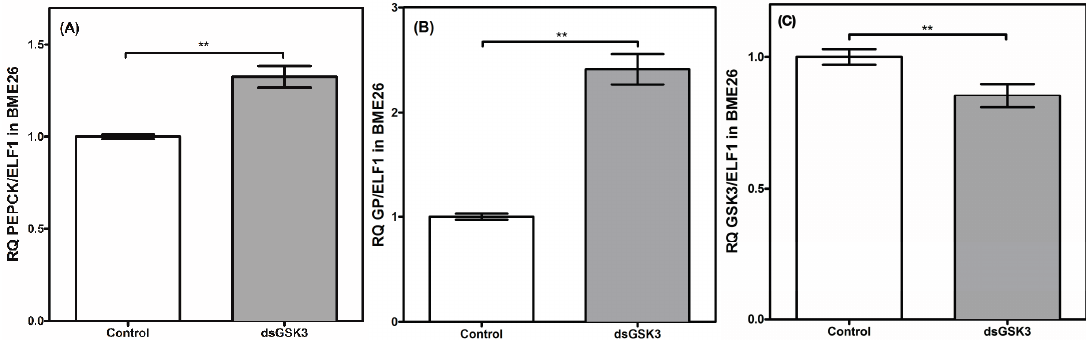
Figure 8. Gluconeogenic enzymes have transcriptional control by GSK3 in BME26 silenced-cells. Transcriptional analysis of PEPCK ( A ) and glucose-6 phosphatase ( B ), gluconeogenic key-enzymes, in embryonic Rhipicephalus microplus cells (BME26) in response to GSK3 silencing ( C ). Control: cells maintained with 50 mM of glucose; Low: cell maintained without glucose addition; and High: cells maintained with 100 mM of glucose. The experiment was performed with three independent biological samples in three experimental replicates each ( ** p < 0.001, paired T